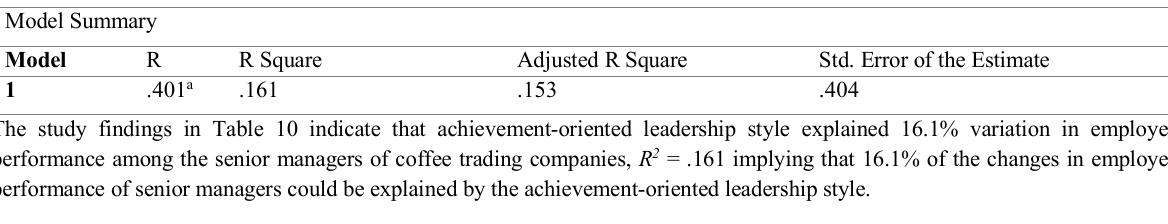
Table 10: Regression model summary for achievement-oriented leadership